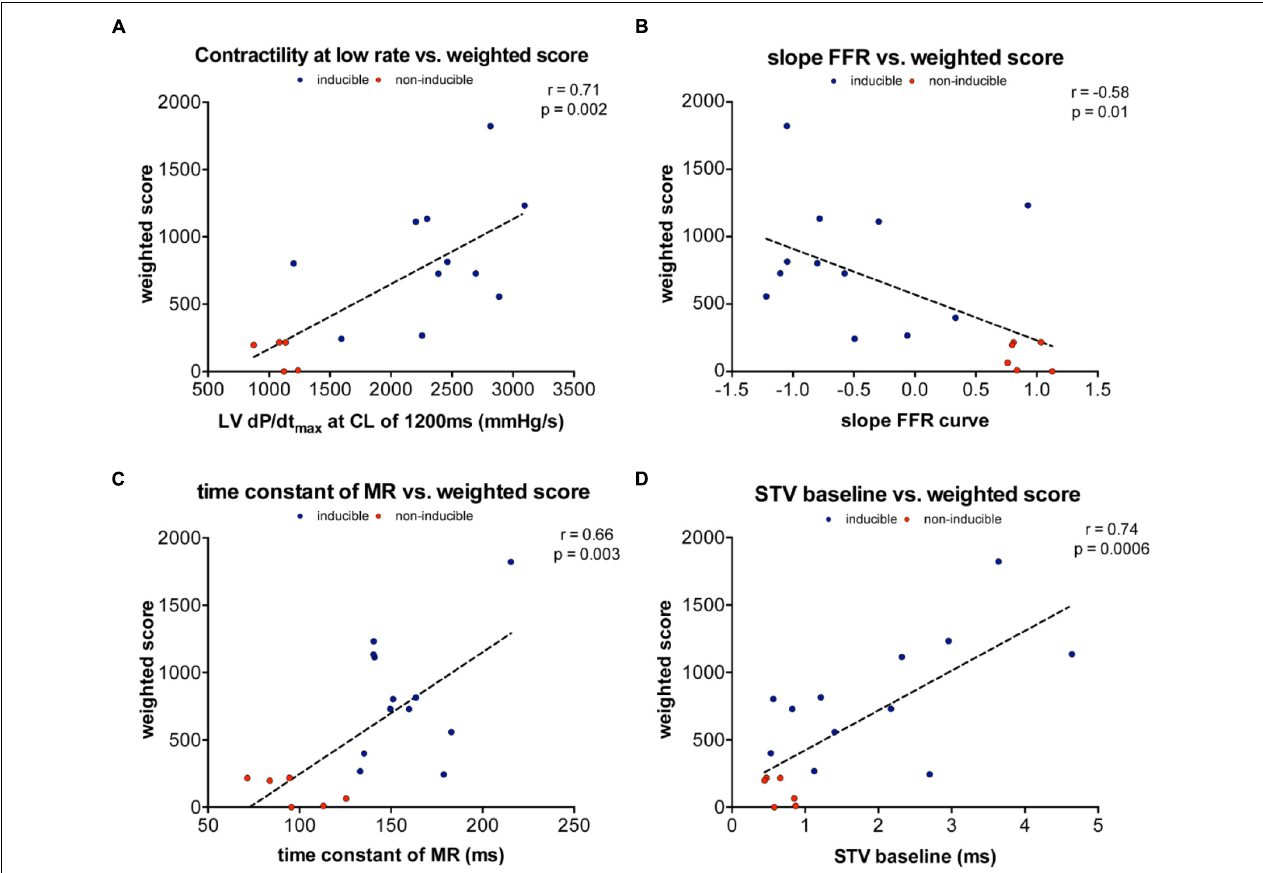
FIGURE 5 | Linear correlations between weighted arrhythmia score and contractile and electrical remodeling. (A) Linear correlation between weighted and contractility at 1200 ms ( r = 0.71, p = 0.002). (B) Linear correlation between weighted score and slope of FFR ( r = –0.58, p = 0.01). (C) Linear correlation between weighted score and TC of MR ( r = 0.66, p = 0.003). (D) Linear correlation between weighted score and STV at baseline ( r = 0.74, p =